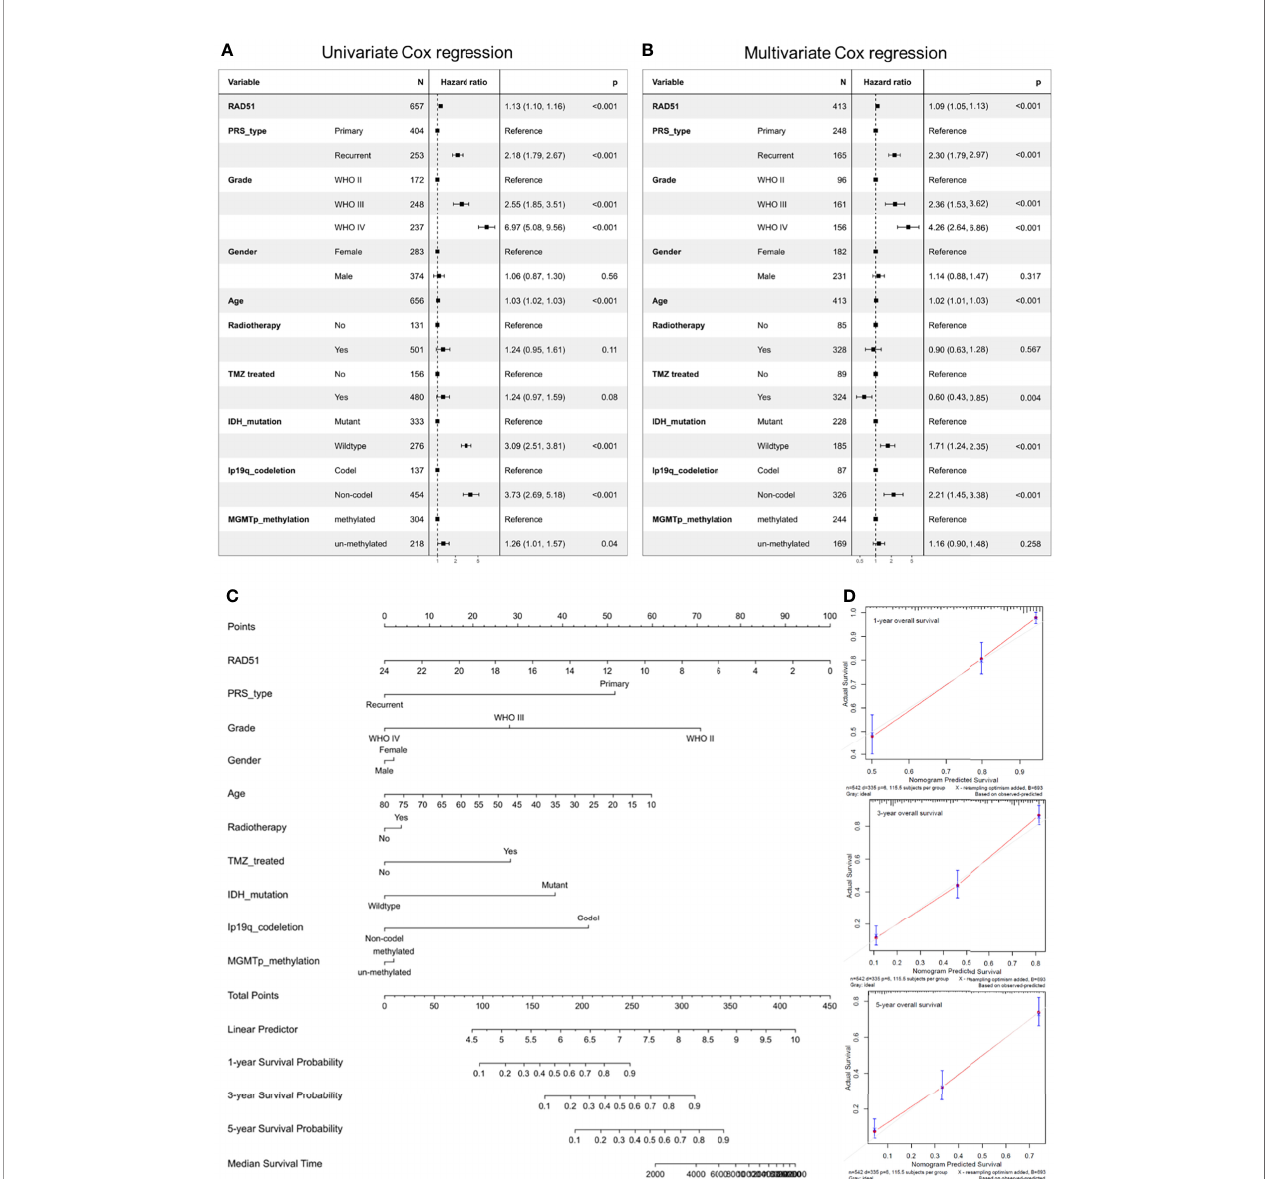
FIGURE 6 | Construction of a prognostic model of RAD51 for overall glioma. The CGGA-mRNAseq_693 cohort was used to construct the model. (A) Univariate Cox regression analysis of overall survival of glioma patients. (B) Multivariate Cox regression analysis of overall survival of glioma patients. (C) Nomogram for the prediction of overall survival of glioma patients. (D) Calibration plots of the